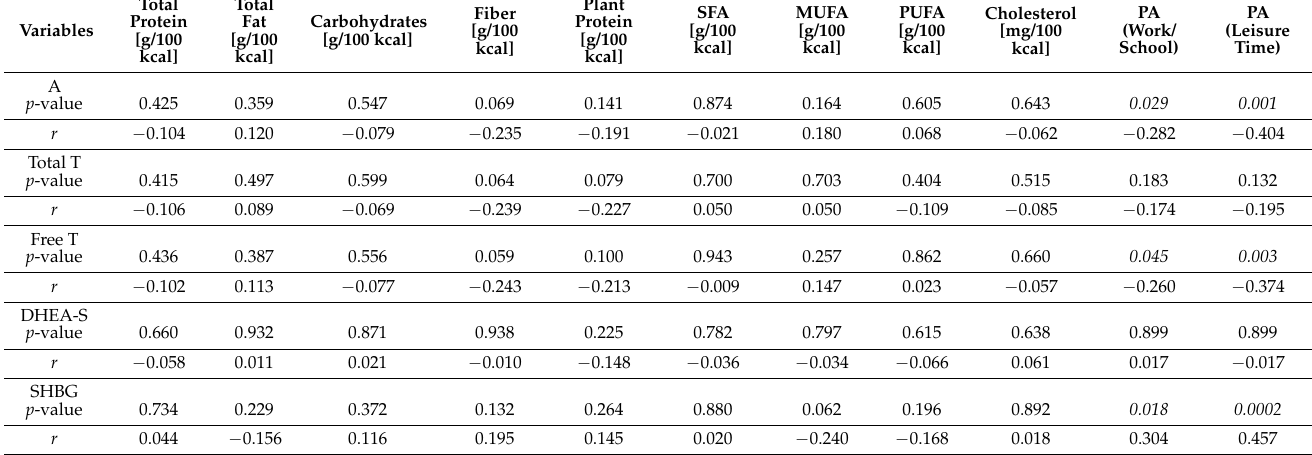
Table 3. Spearman’s correlation coefficients among serum androgen levels and macronutrient intake adjusted for total energy intake (per 100 kcal) and PA (PCOS